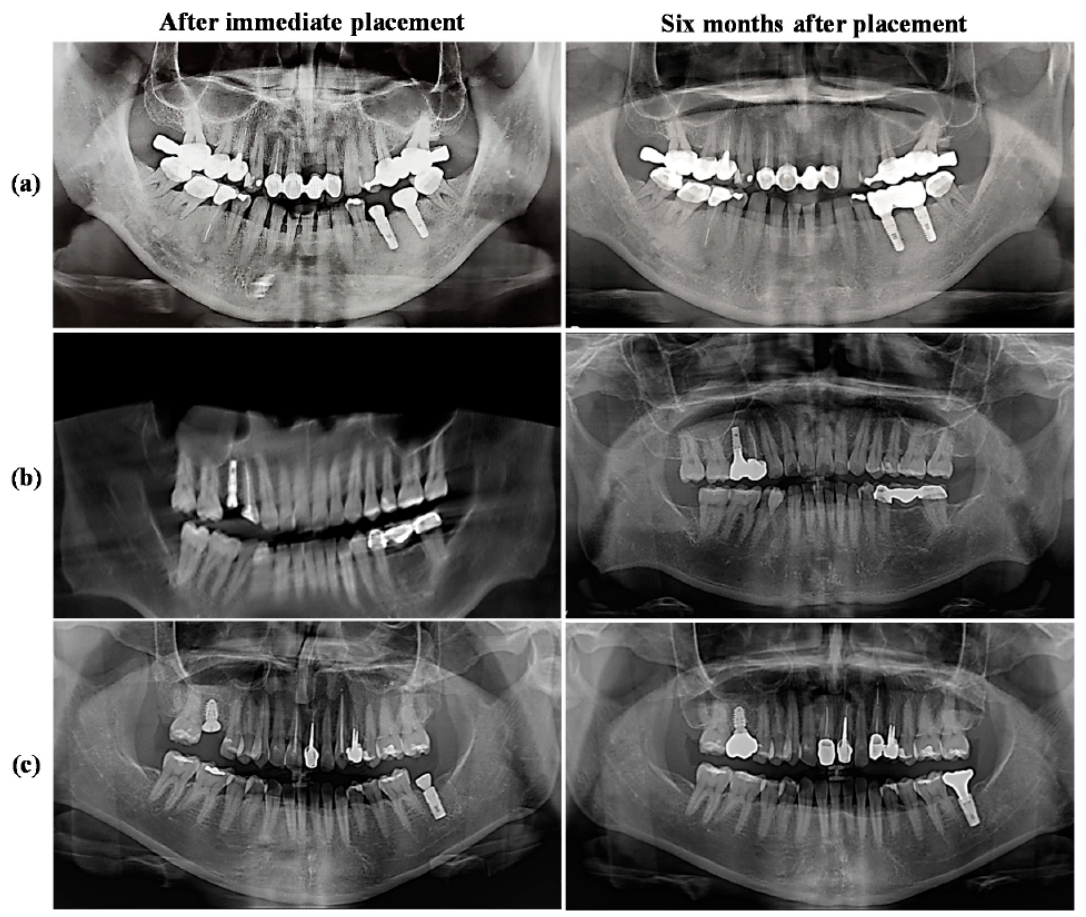
Figure 7. The panoramic of IDCT-Ti/GRGD-1 implant in ( a ) mandibular, ( b ) maxillary, and ( c ) maxillary and mandibular region, immediately and six months after placement. Note: figure ( b ) after immediate implant placement is the picture that was reconstructed from the cone-beam computed